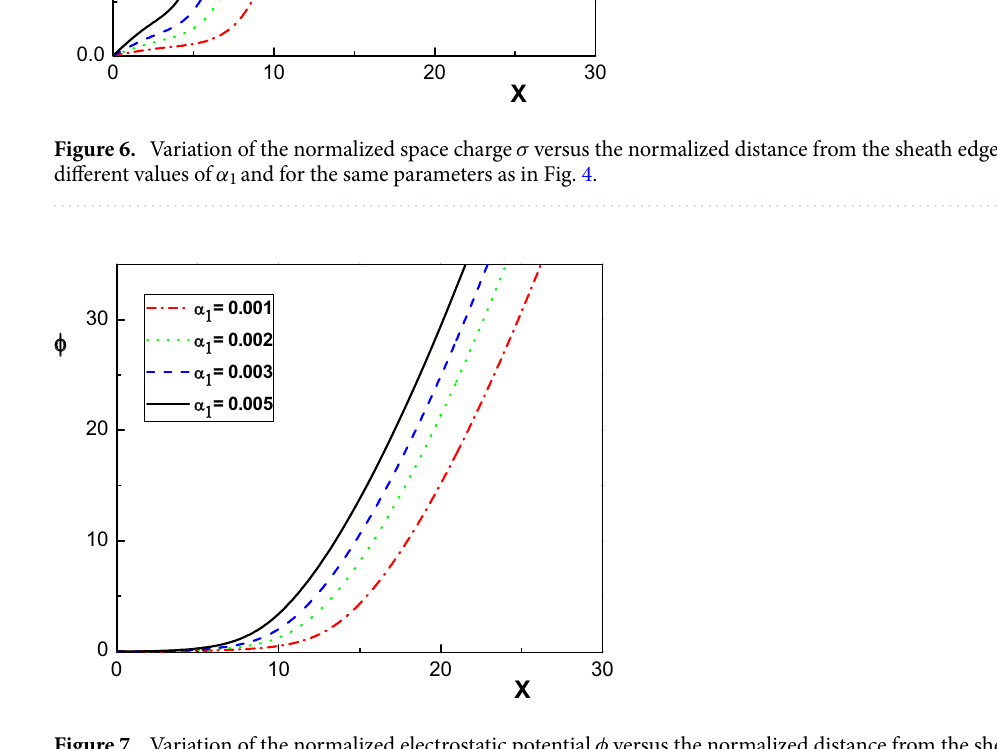
Figure 7. Variation of the normalized electrostatic potential φ versus the normalized distance from the sheath edge, for different values of α 1 and for the same parameters as in Fig.